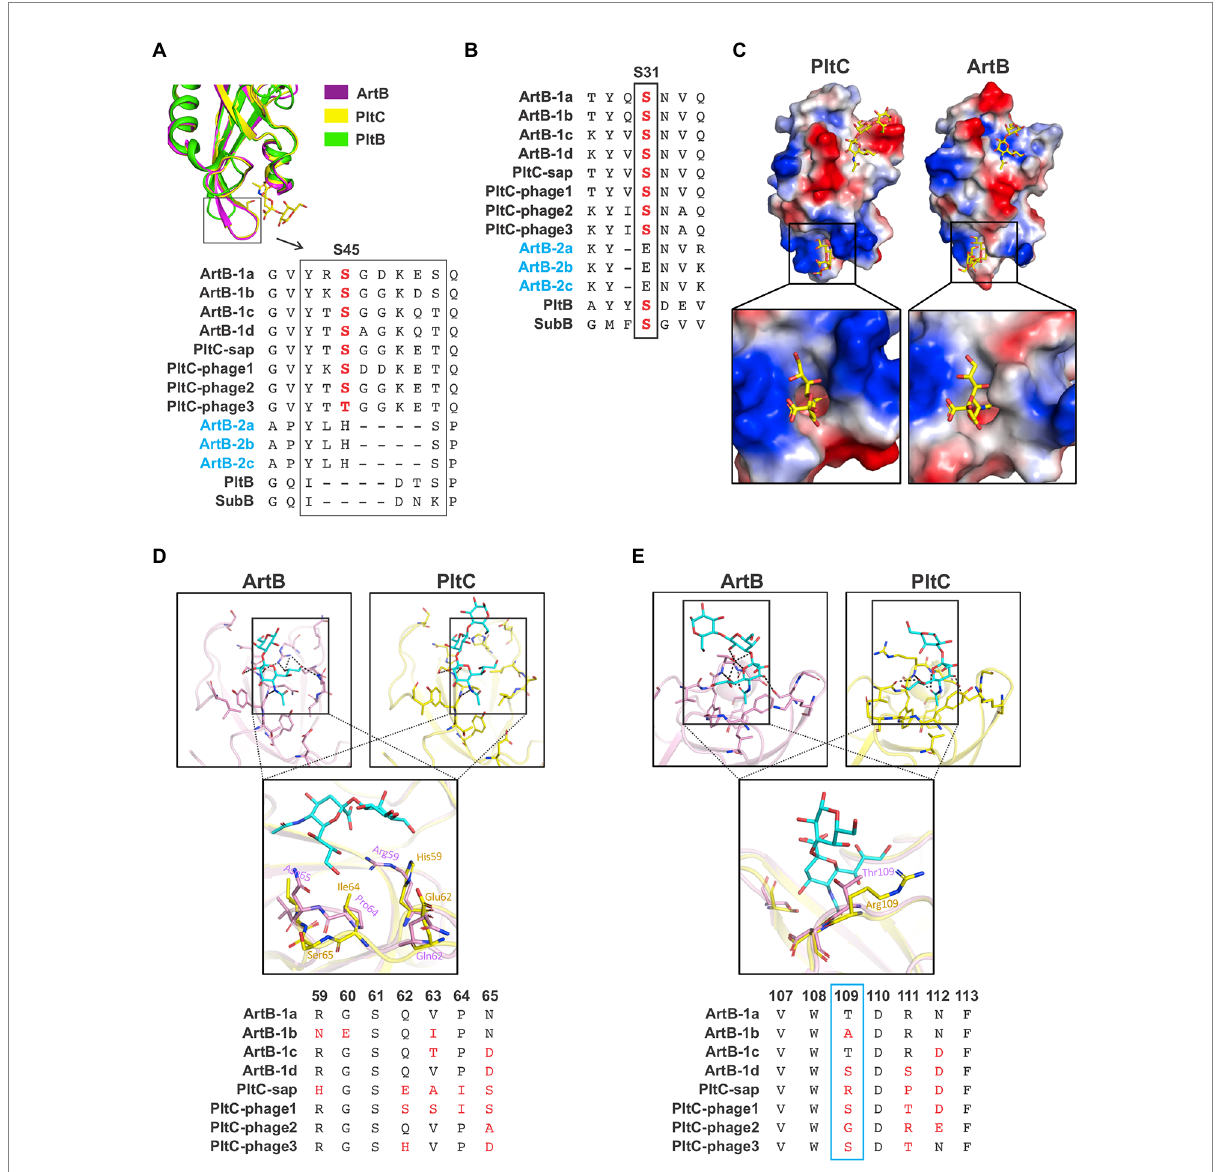
FIGURE 4 Analysis of the diversity within the glycan binding pockets of different Salmonella ArtB subtypes and PltC groups. (A) Conservation of the basal glycan binding site. Ribbon diagram shows the overlaid structures of the basal binding sites from S . Typhimurium DT104 ArtB and S . Typhi PltC as well as the structure of PltB, which lacks the basal binding site. Sequence alignments of each ArtB subtype and PltC group show the four amino acid insertion that yields the extended loop that forms a key structure of the basal binding site, as well as the critical glycan-binding serine residue within this loop. The absence of these features in type 2 ArtB subtypes suggests that they lack this binding site. (B) Conservation of the lateral glycan binding pocket. Sequence alignment shows the conservation of a serine residue (labelled S31, its position in PltC/ArtB) that is essential for glycan binding at this site in various B subunits from this family of toxins, including each type 1 ArtB subtype and PltC group. This alignment suggests that type 2 ArtB subtypes might lack this binding pocket, or that it might vary substantially from the pocket in type 1 ArtB subtypes. (C) Electrostatic potential surface view of the Neu5Aca2-3Galb1-3Glc-bound structures of S . Typhi PltC and S . Typhimurium DT104 ArtB (sugars are shown as sticks), highlighting the shape and charge distribution within their glycan binding pockets. Inset shows a zoomed in view of the basal (S45) binding site. (D,E) Ribbon diagrams of the binding pockets of S . Typhi PltC and S . Typhimurium DT104 ArtB and overlays that highlight key variable regions of these pockets. Accompanying sequence alignments show the pertinent region of each type 1 ArtB subtype and PltC group. (D) The lateral binding site. (E) The basal binding site. The PDB identifiers for the structures shown are: ArtB; 5WHU, PltC; 7EE4, PltB;